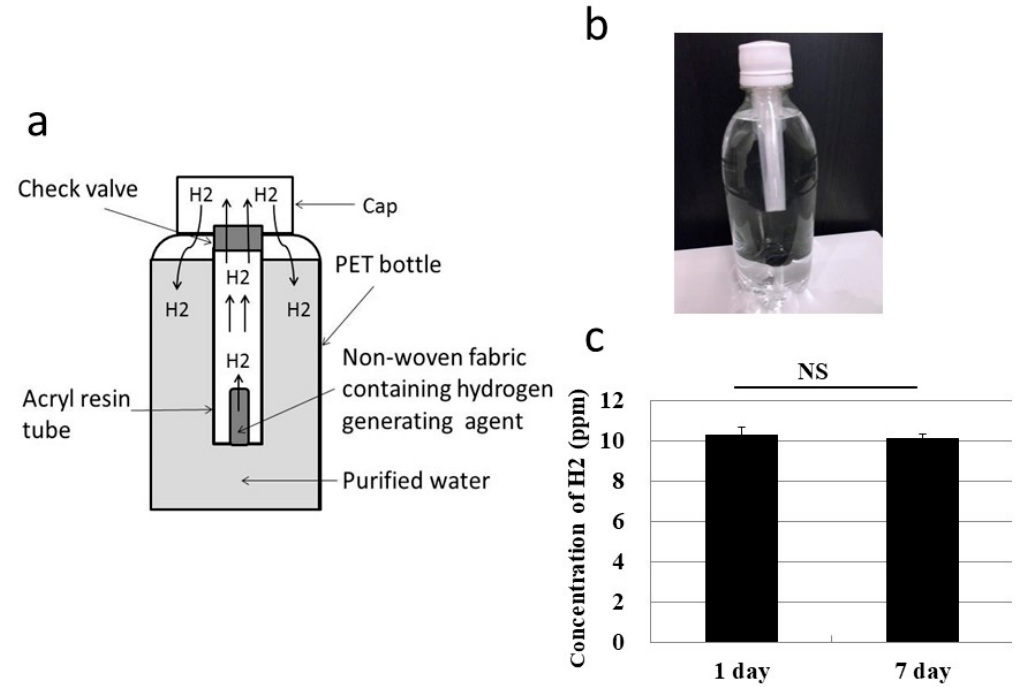
Figure 2. ( a , b ) Device for super-saturated hydrogen (H 2 ) water. In a pressure-resistant polyethylene terephthalate (PET) bottle, a non-woven fabric containing a water-wetted H 2 -generating agent was inserted into an acrylic resin tube. In about 5 min at room temperature, the H 2 gas generated in the tube was released into the bottle. After 24 h, the PET bottle was shaken for about 30 s and 10 ppm water was obtained. ( c ) The concentration of 10 ppm water can be maintained for about a week. Data are shown as mean ± standard deviation (SD) for 3 or 5 experiments.